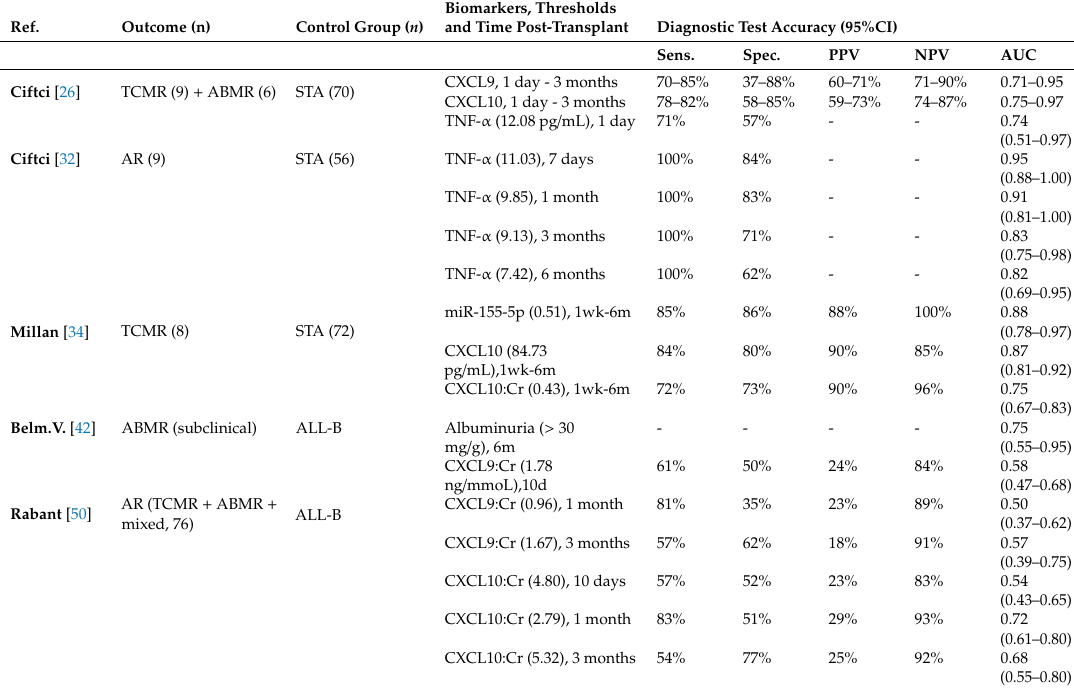
Table 5. Summary of the study results—Predictive studies with DTA. This table shows the outcome of prediction studies. Outcome and control group for the DTA analysis are reported (sample size when available), followed by the studied urinary biomarker(s), thresholds and time from transplant to test. Biomarkers, Thresholds Ref. Outcome (n) ControlGroup( n ) and Time